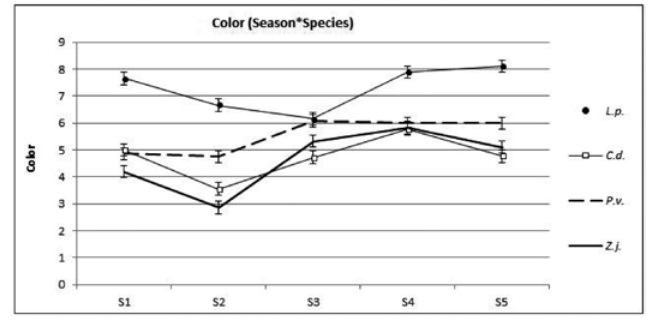
test.Fig. 2 - Average color of the species under investigation during the trial period (assessment with 1-9 scale). Bars = standard error.